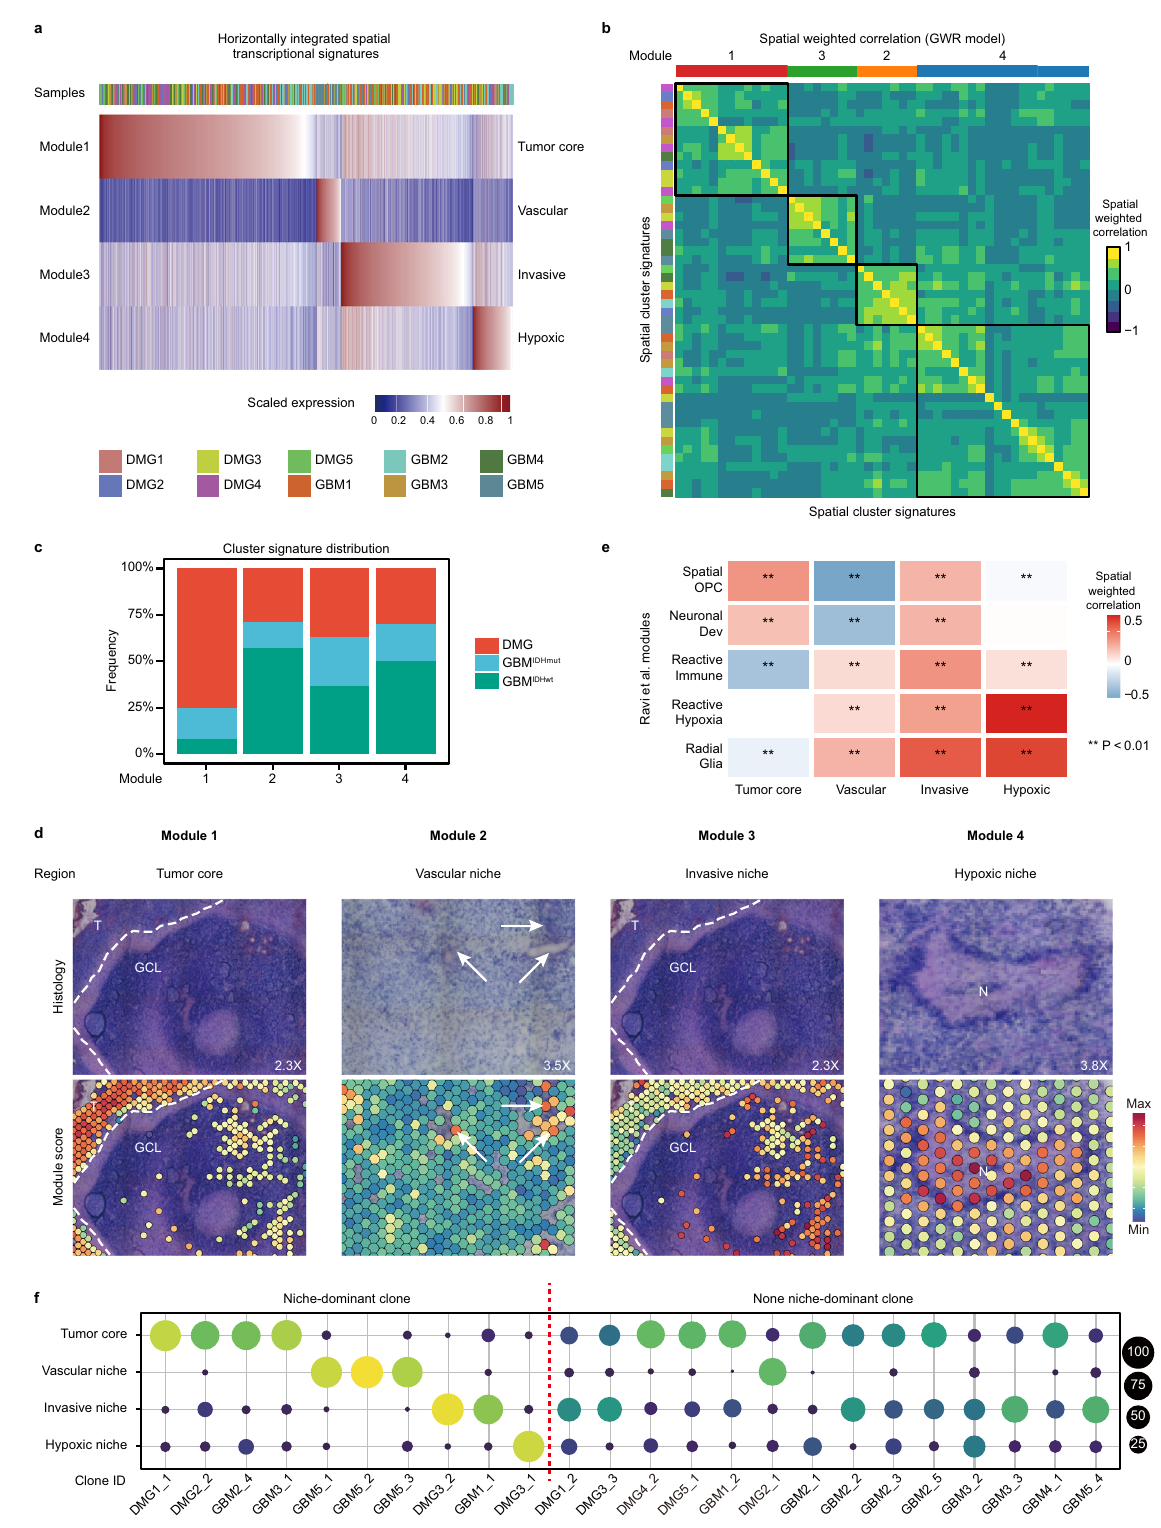
Fig.2|Niche-speci fi cspatialtranscriptionalprogramsandtheirrelationshipto subclonal architecture. a Heatmap of horizontally integrated spatial transcrip- tionalsignatures/modulesexpressedinallmalignantspots( n =19,767).Thesample identify for each spot is shown by different colors in the top bar. b Heatmap of GWR-based, spatially weighted correlation of the 48 spatial cluster signatures, marked by different colors on the left. Hierarchical clustering con fi rmed 4 clus- tered programs that correspond to the four modules in a , marked by different colors on the top. c The percentages of cluster signatures per tumor type con- tributingtoeachprogramareshown. d Representativeexamplesofthecorrelation